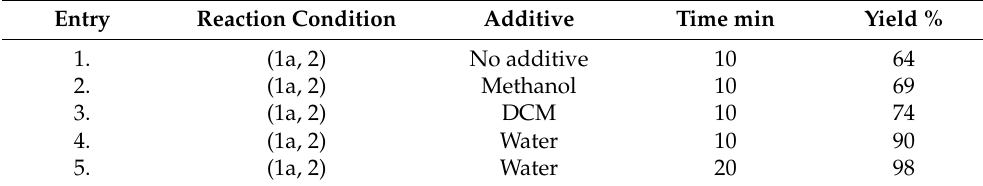
Scheme 2. Synthesis of 3-dicyanomethylene-2H-indol-2-ones (3a) under mechanochemical activa- tion without any additive. Table 2. Optimization of the model reaction conditions for (Step